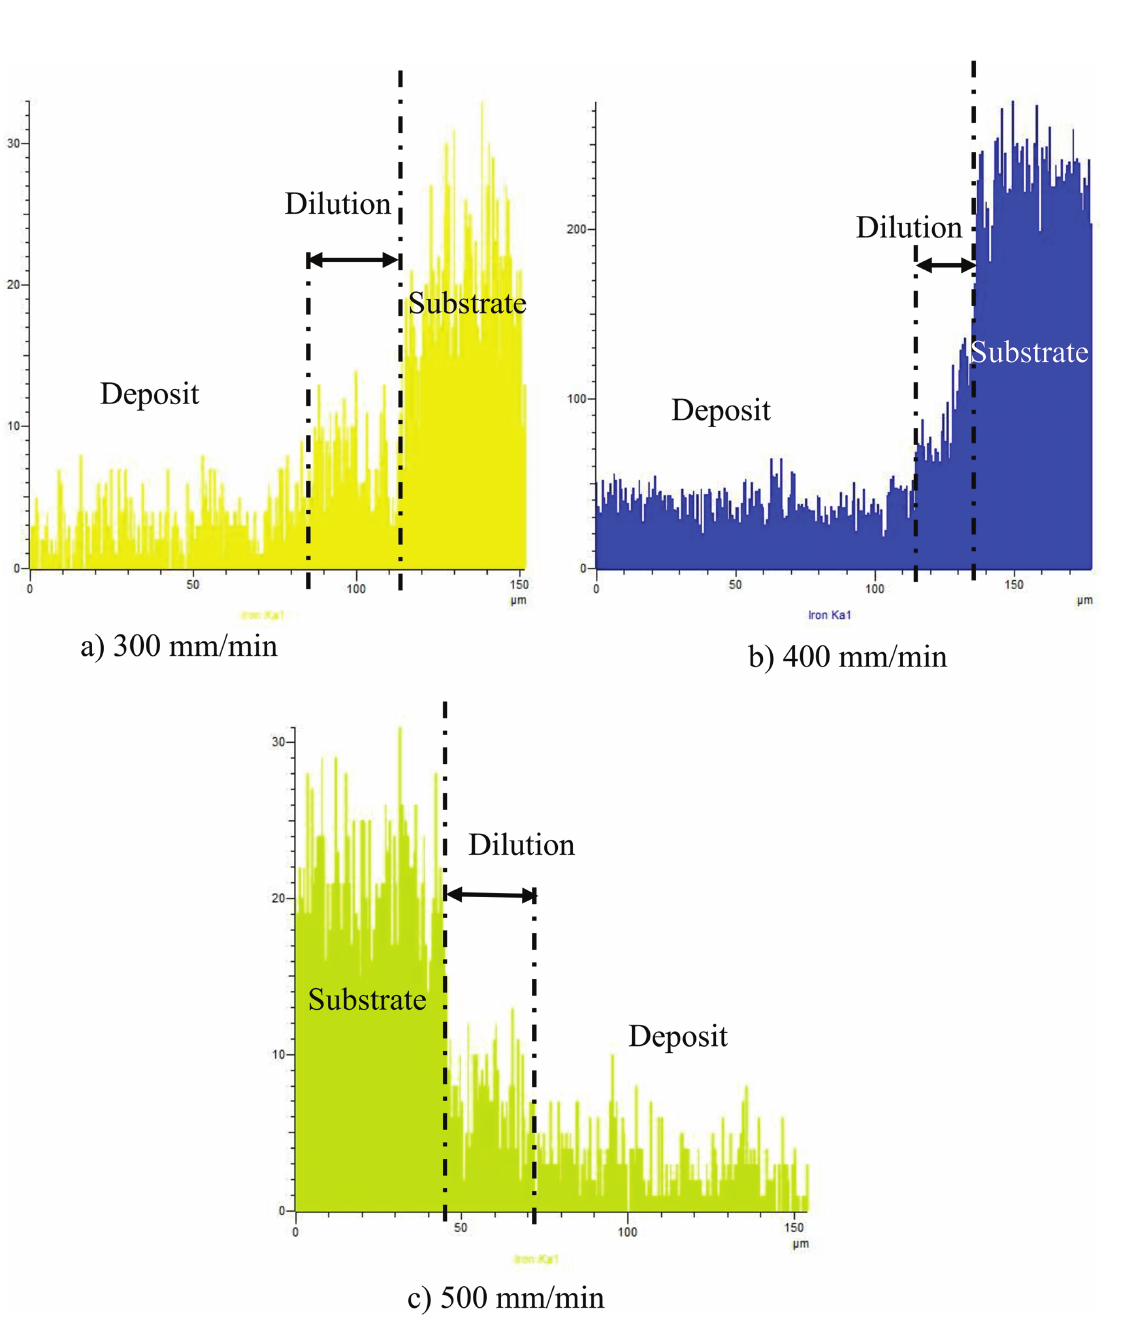
Table 6. Wear tests were carried out under self-mating condition at room temperature. Maximum weight loss at the initial stage of the wear test is recorded. Weight loss is attributed to the asperities on the wear surface of specimens, which result in the confined contact area of the friction pair than its nominal counterpart. With the test running, the asperities flake off the surface, and the weight loss stabilized [31, 32].